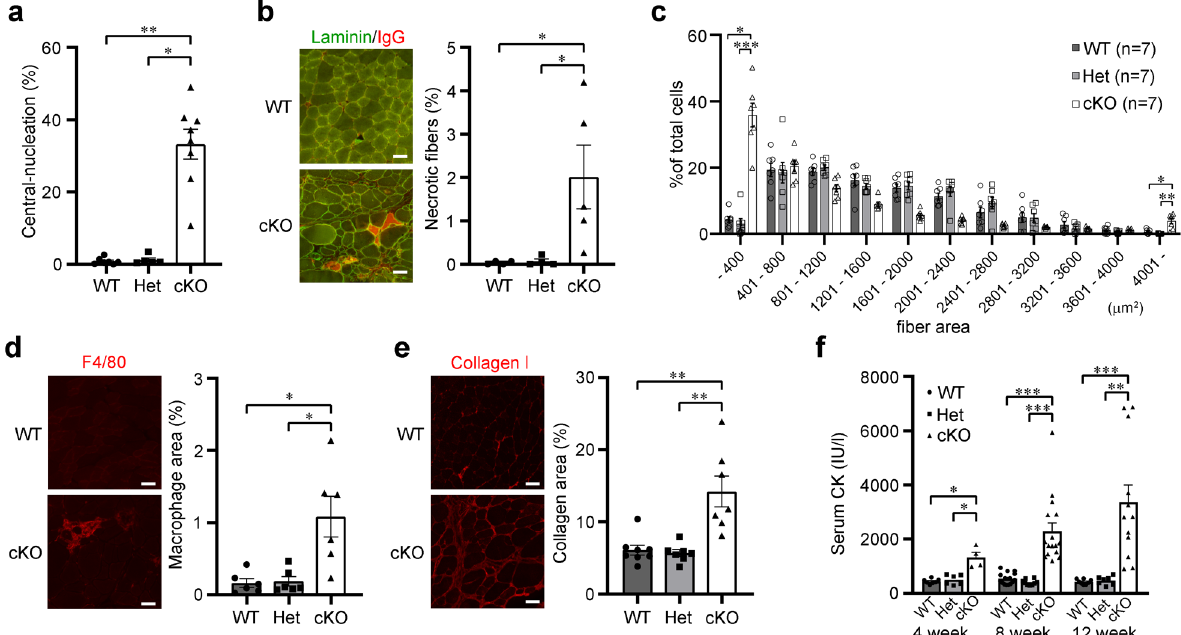
Fig. 2 Quantitative analysis of skeletal muscle pathology in Myf5- Ispd -cKO mice. a Quanti fi cation of myo fi bers with centrally located nuclei ( p = 0.0015, cKO vs. WT; p = 0.021, cKO vs. Het. WT, n = 7; Het, n = 5; cKO, n = 8). b Immuno fl uorescence and quantitative analysis of necrotic fi bers. Percentage of muscle fi bers (TA) with intracellular IgG signals ( p = 0.035, cKO vs. WT; p = 0.035, cKO vs. Het. WT, n = 4; Het, n = 4; cKO, n = 5). c Quantitative analysis of myo fi ber size variation ( p = 0.029, cKO vs. WT; p = 0.0005, cKO vs. Het < 400 μ m 2 ; p = 0.047, cKO vs. WT; p = 0.001, cKO vs. Het > 4000 μ m 2 ; n =